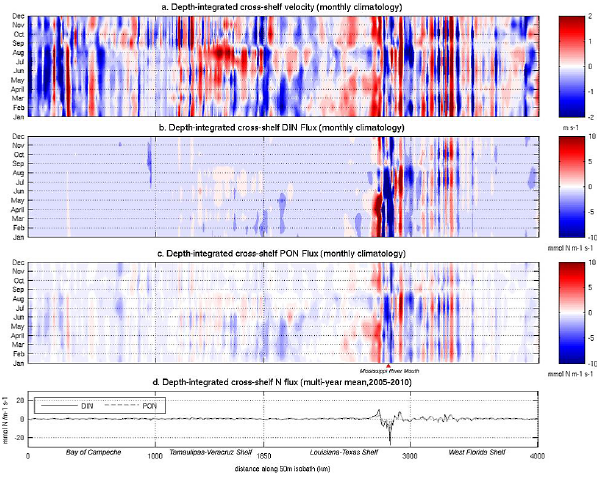
Fig. 13. Seasonal mean surface current and wind fields in the BOC shelf in (a) spring, (b) summer, (c) autumn, and (d) winter. Also shown is regional along-shelf nitrogen transport (blue arrows, unit: 10 9 molN), cross-shelf nitrogen transport (red arrows, unit: 10 9 molN), river inputs (unit: 10 9 molN) and nitrogen removed by denitrification (DNF, unit: 10 9 molN), and 50m isobath (grey